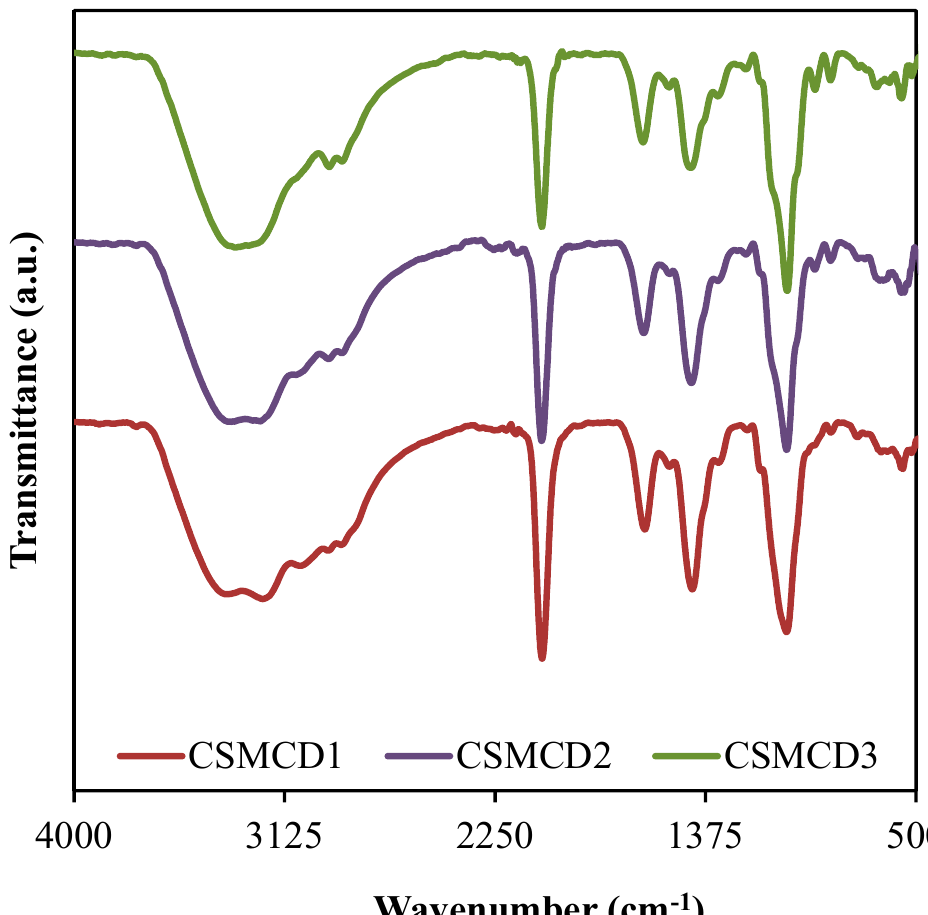
Figure 2. FTIR spectra of the electrolytes. The vibrational peak at 3407 cm − 1 (CSMCD1) corresponds to the O–H stretching, where the high intensity of this peak exposed the well-developed interaction that leads to the increase in ions dissociation which is important in increasing the conductivity [61,62]. As mentioned by Hamsan et al. [63], the indicator of an interaction between two polymers in a polymer blend system can be determined through the peaks shifting of the functional groups containing oxygen atoms such as hydroxyl and ether groups. In the